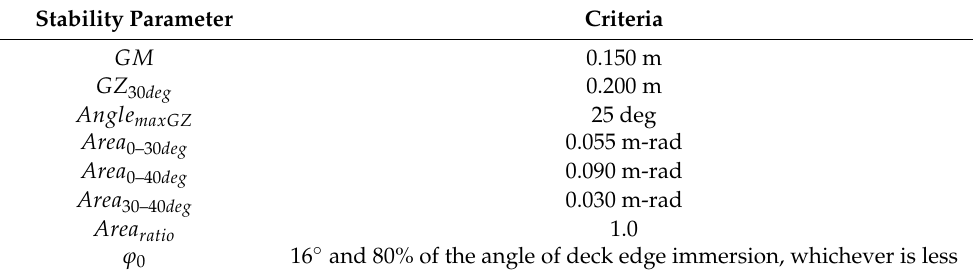
Table 3. IMO intact stability parameters and criteria. Stability Parameter